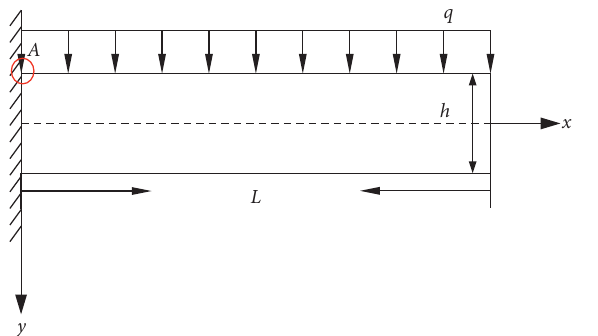
Figure 4: Stress analysis diagram of internal